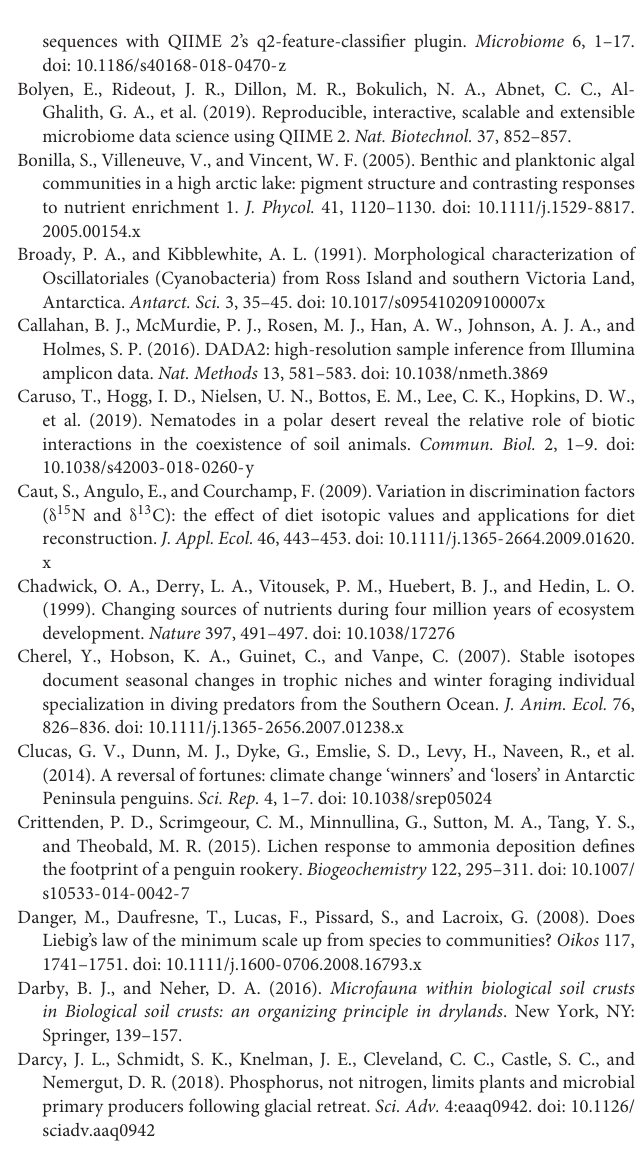
are presented as per mille ( ) and related to the international standards of the Pee Dee Belemnite for carbon and atmospheric N 2 for nitrogen. Standard (cid:104) deviation (SD) is shown between parentheses. Supplementary Table 2 | DESeq analysis of ASVs (family level) comparing the different microbial mats. Families significantly different in abundance between “penguin-affected” and “macrofauna-free” microbial mats are